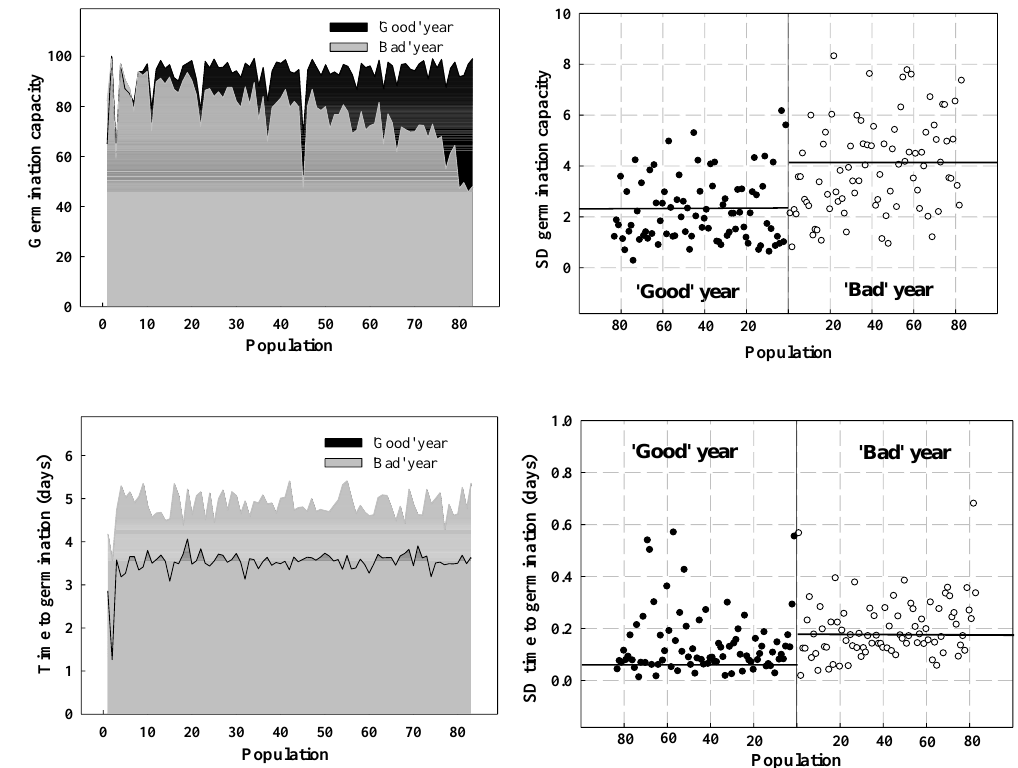
Figure 5. Studies of bet-hedge strategy. Bet-hedge dormancy involving germination capacity and time to germination (left) and their SD (right) in response to “good-year” and “bad-year” treatments. Note: the population was ranked as per its current DI in ascending